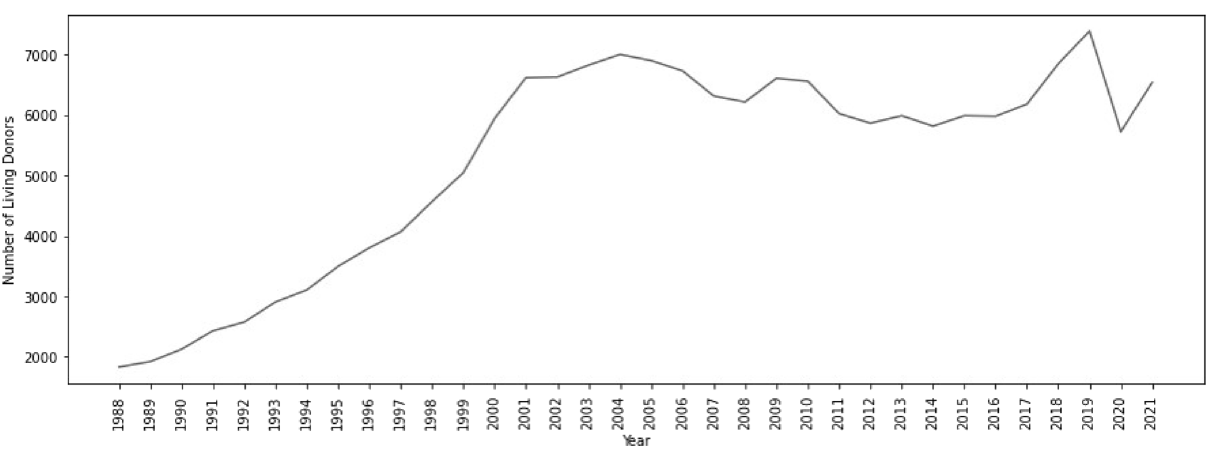
Figure 3. Total number of USA living organ donors per year,